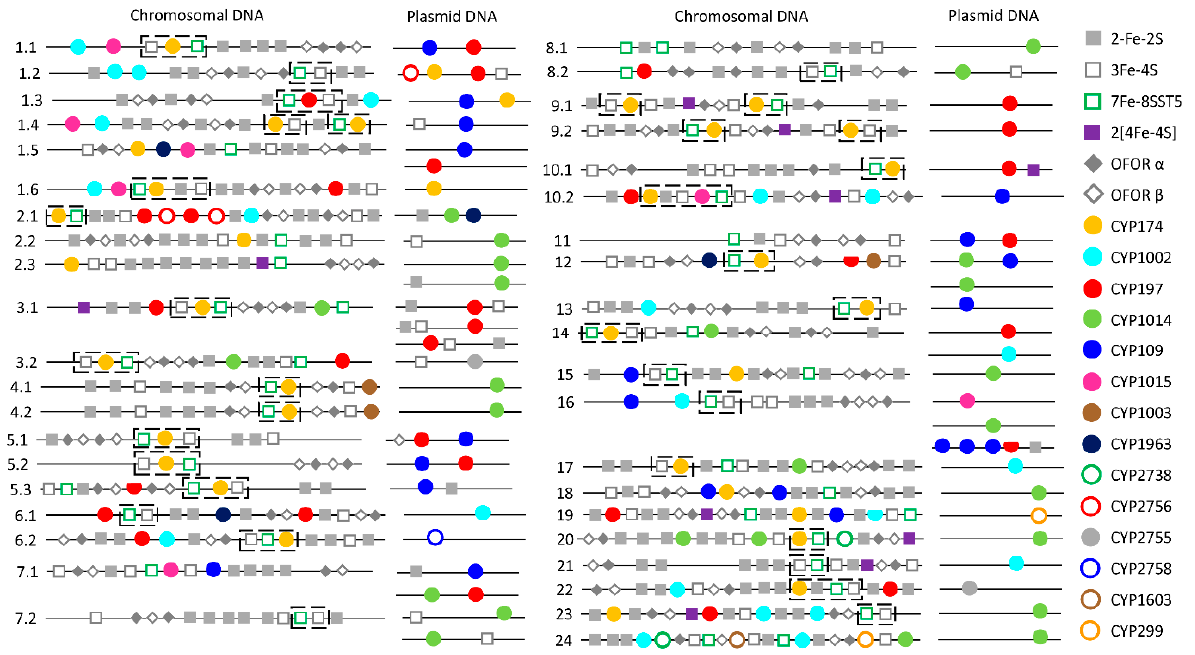
Figure 3. Schematic representation of P450s, ferredoxins and ferredoxin reductase (OFOR) on chromosomal and plasmid DNA from 40 archaeal species. The numbers 1 to 24 represent archaeal species belonging to different genera and subsection numbers such as 1.1, 2.1, etc., represent species in a genus. P450s are presented with circles (filled or empty), where a half-filled circle indicates a P450 fragment. Ferredoxins are represented per their iron-sulfur cluster type and OFOR with alpha and beta subunits. A dashed line box shows the association between CYP174, 3Fe-4SST1 and 7Fe-8SST5. P450s, ferredoxins and ferredoxin reductase alpha and beta subunits. Detailed information is presented in Tables S5 and S6.